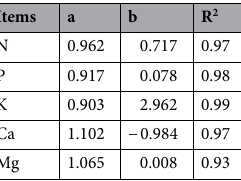
Table 5. The constants a, b and coefficient of determination for nutrients